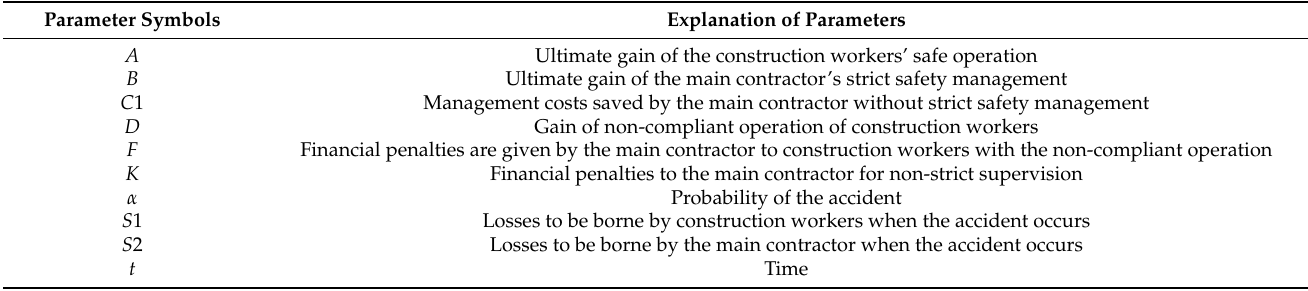
Table 1. Parameters in evolutionary game